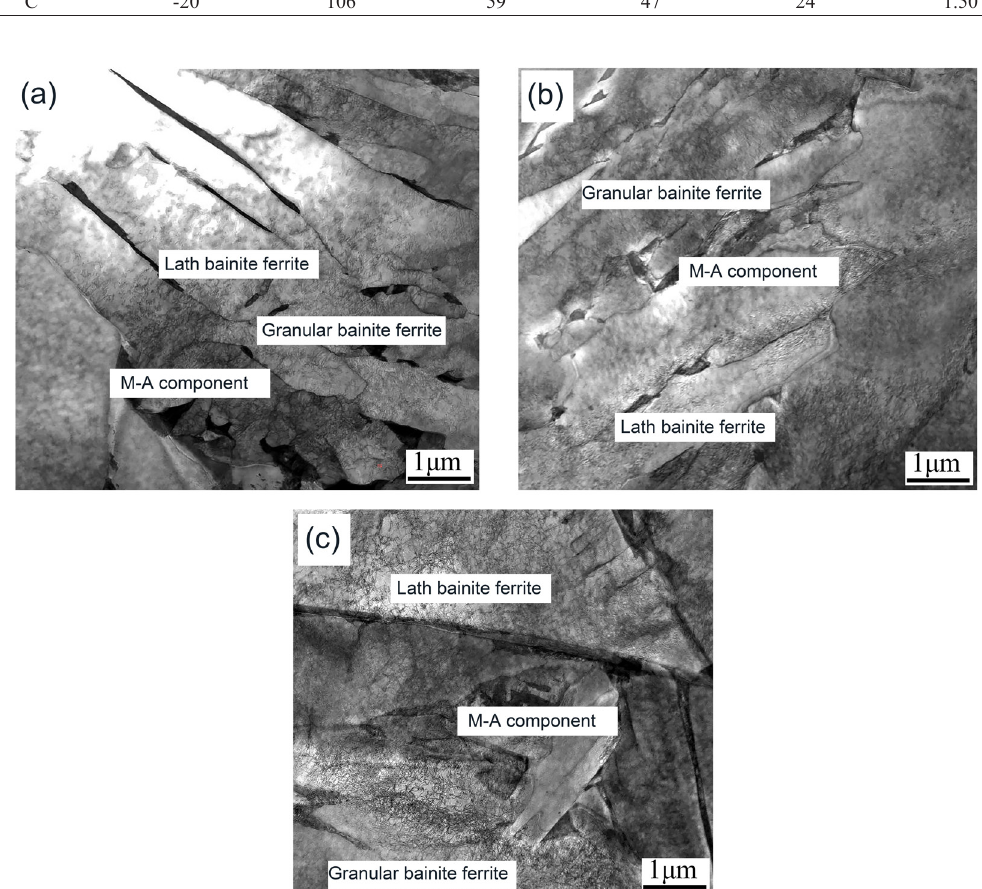
Figure 3. TEM morphology of CGHAZ joint under different the welding heat input: (a) 18kJ·cm -1 , (b) 24kJ·cm -1 and (c)30kJ·cm -1 .